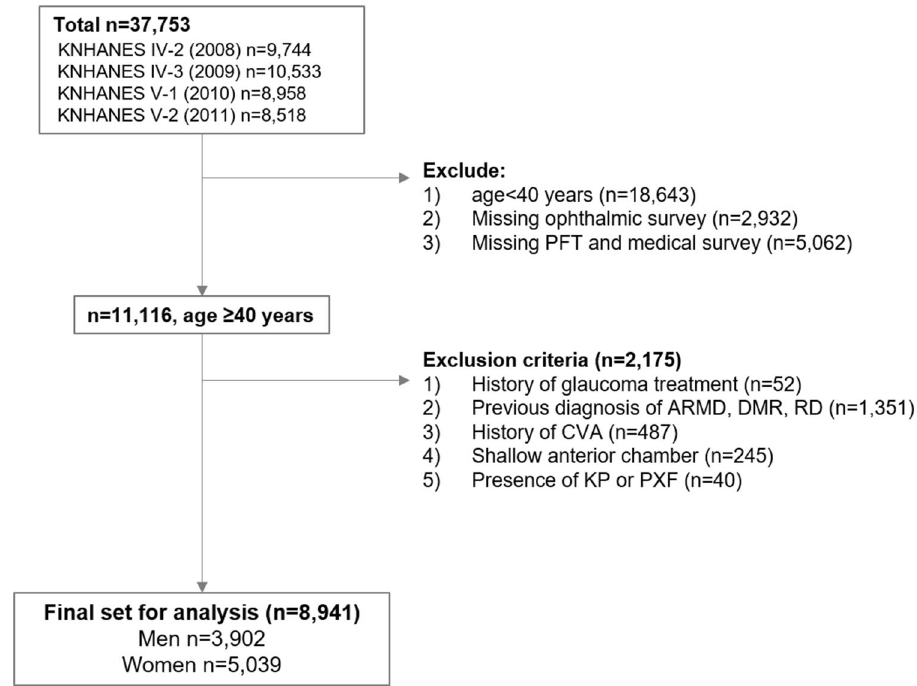
Figure 1. A flowchart of subject inclusion for the study. Of 37,753 subjects from Korea National Health and Nutrition Examination Survey (KNHANES), 8941 subjects were included for analysis in this study. PFT pulmonary function test, ARMD age-related macular degeneration, DMR diabetic retinopathy, RD retinal detachment, CVA cerebrovascular accident, KP keratic precipitates, PXF pseudoexfoliation, IOP intraocular